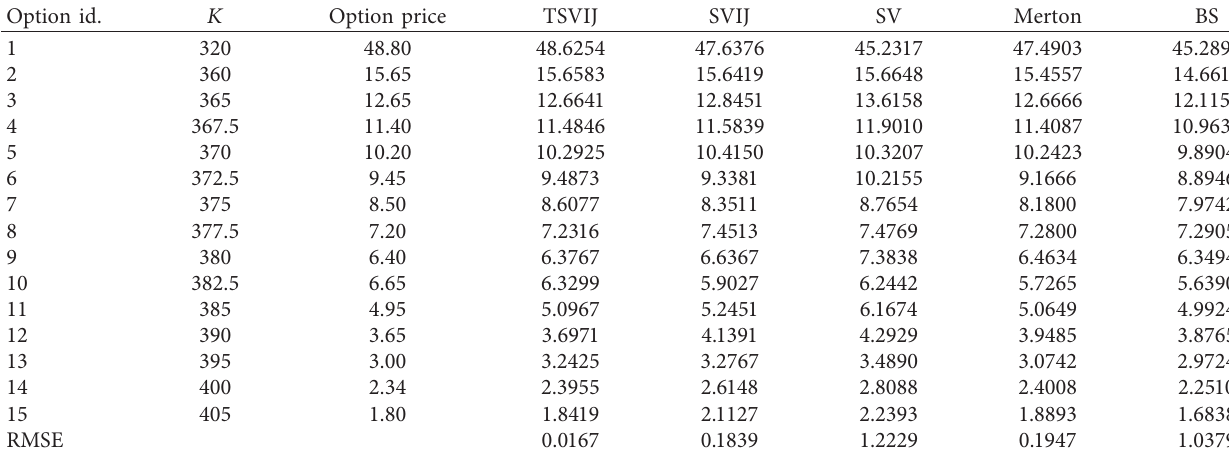
Table 6: Out-of-sample pricing results.